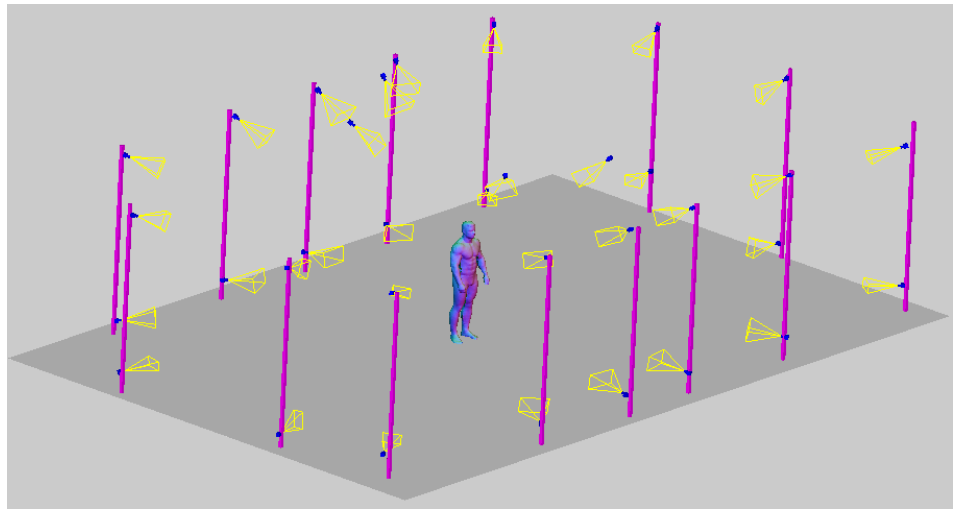
Figure 1. Visualized measurement scene with 34 camera distribution and sample-measured subject SfM point cloud.